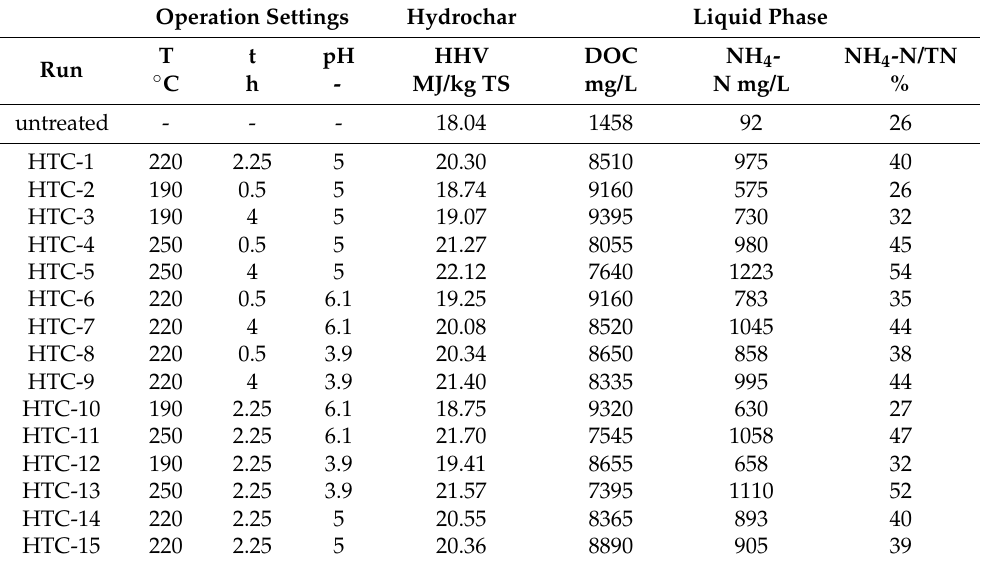
Table 2. Variables of the BBD and the results for the solid phase and the liquid phase of RS1. The spread of the measuring values was evaluated using the mean value and the deviation of each measured value to the mean value. The maximum deviations are ± 0.8% for HHV, 3.7% for DOC and 1.7% for NH 4